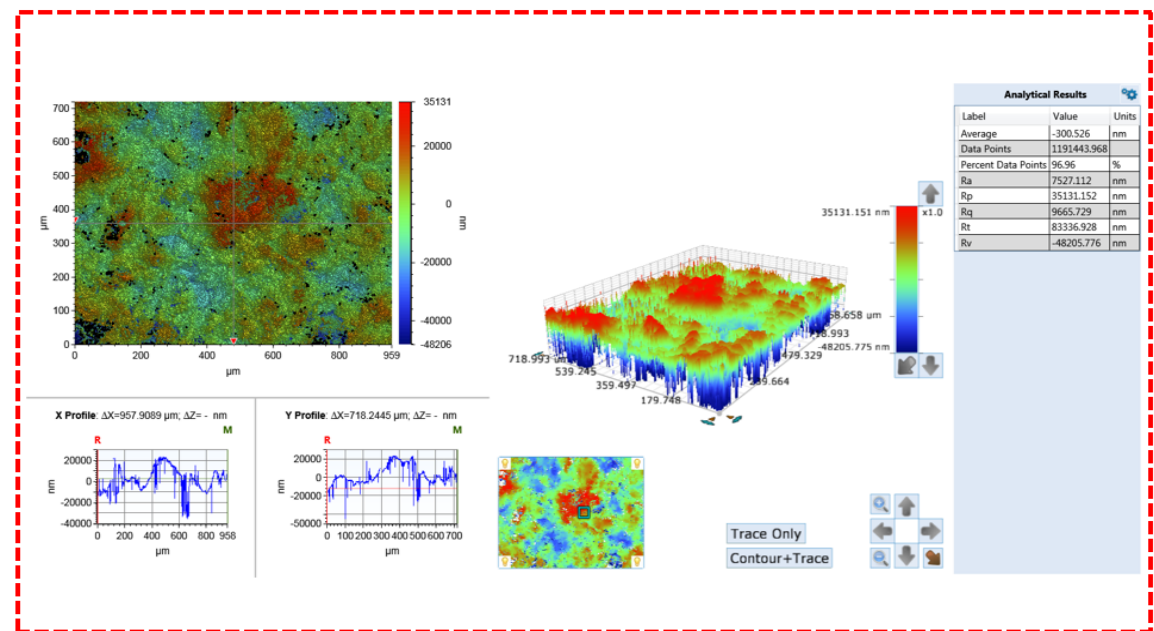
Figure 6. 2D and 3D morphologies of the self-made bonded abrasive polishing pad.